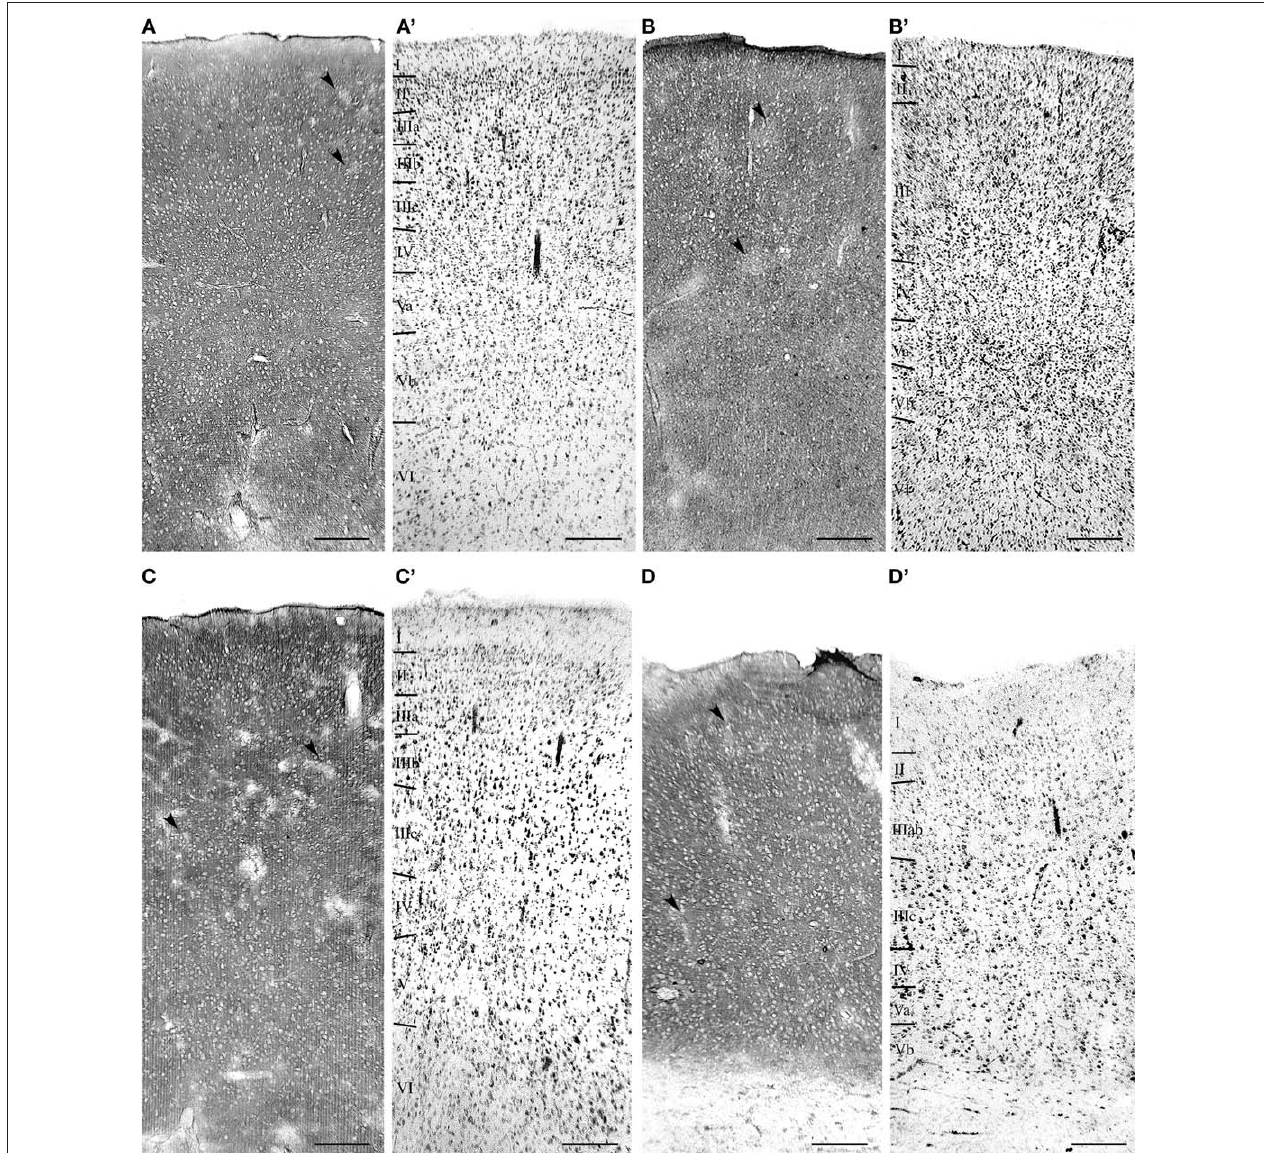
FiGurE 3 | Distribution of EAAT2a-ir in human cerebral cortex. (A–D) EAAT2a-ir in prefrontal [ (A) area 46; HBC 980510], parietal [ (B) area 7; HBC 050230], temporal [ (C) area 21; HBC 981114], and cingulofrontal transitional [ (D) area 32; 970105] cortices. (A ′ –D ′ ) Adjacent Nissl-stained sections. Arrowheads indicate sparse and irregular patchy areas of limited EAAT2a-ir. Roman numerals indicate cortical layers. WM, white matter. Scale bar: 250 μm for (A–D,A ′ –D ′ )